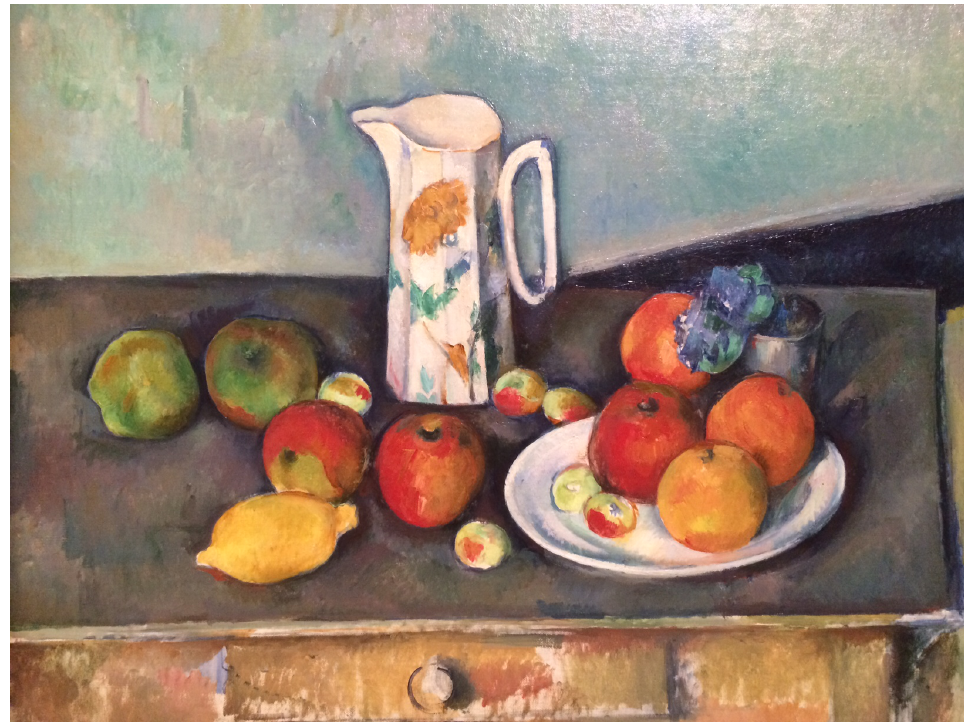
Figure 2: Paul Cézanne, Still life